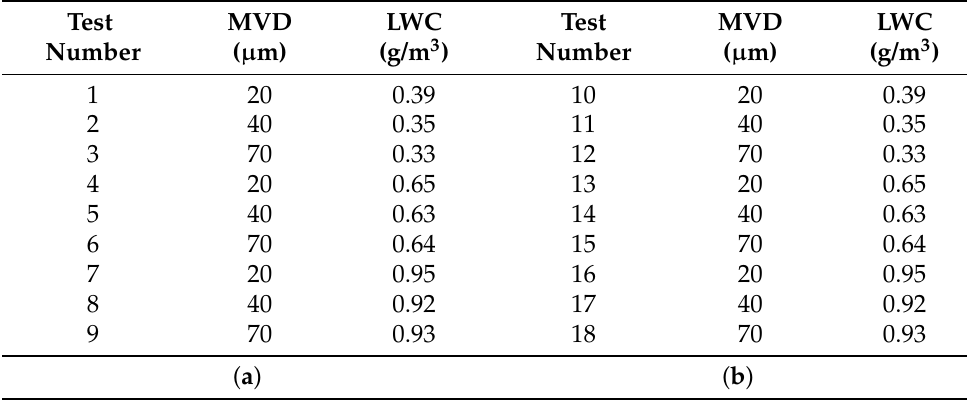
Table 3. Test Matrix. ( a ) T t ≈ 5 ◦ C. ( b ) T t ≈ 13.5 ◦